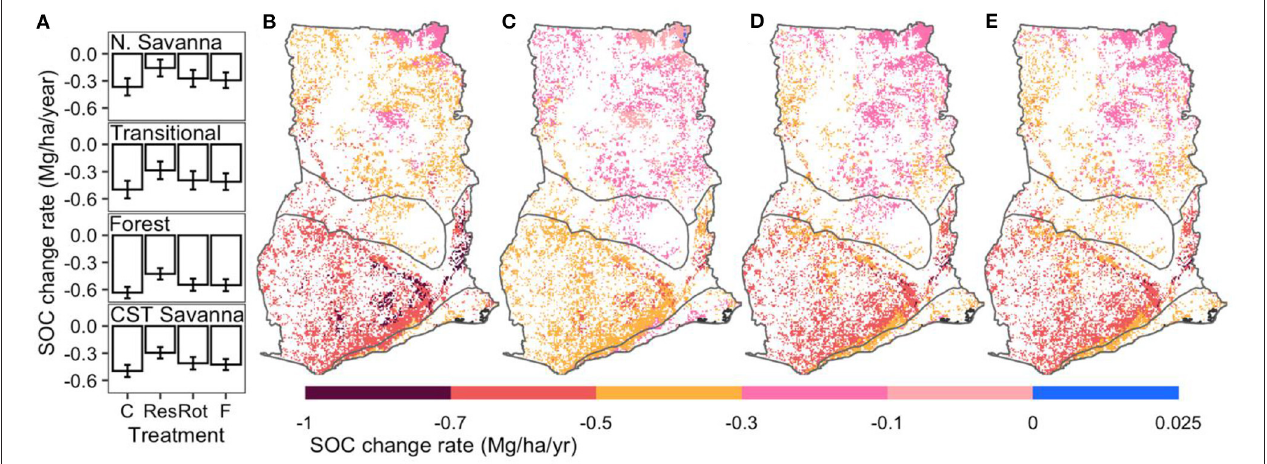
FIGURE 9 | Response of soil organic carbon (SOC) change rate to management treatments across Ghana. (A) Average SOC change rate by agroecological zone under the four treatments, and (B–E) SOC change rate under the four respective treatments: control, pigeonpea residue incorporation, pigeonpea–yam rotation, and yam with fertilizer addition. N. Savanna, northern savanna; CST savanna, coastal savanna; C, control; Res, residue; Rot, rotation, and F, fertilized. Source: Liu et al. (2021) .